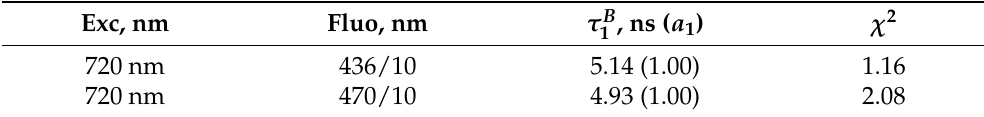
Table 4. Fluorescence decay times τ B one-exponential model.